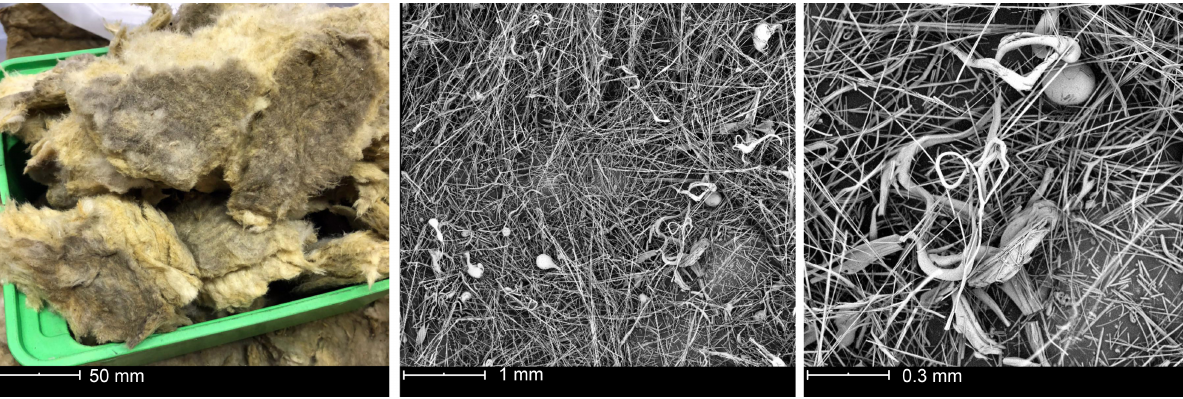
Figure 3. Representative optical and SEM images of demoliation mineral wool waste before processing in the recycling line (set